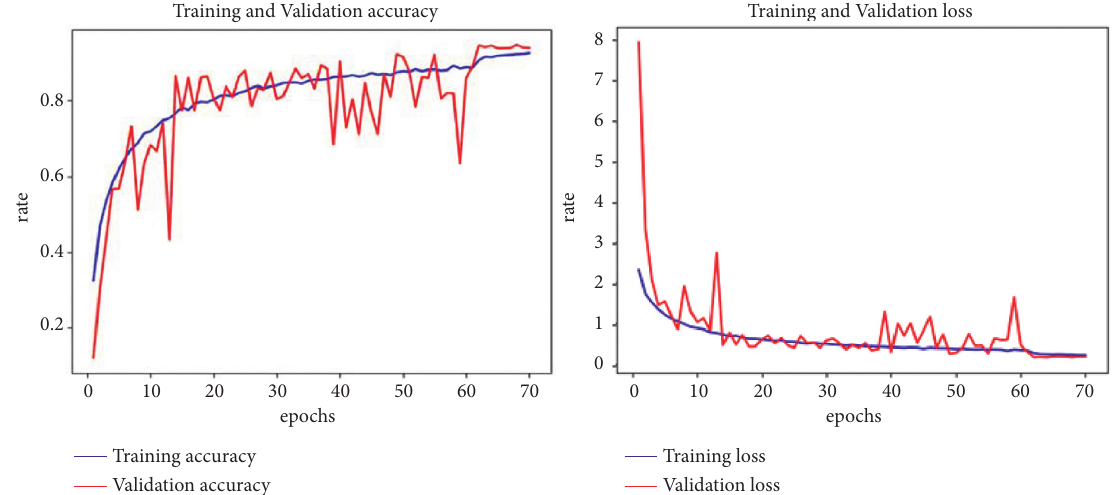
Figure 14: Curves of accuracy and